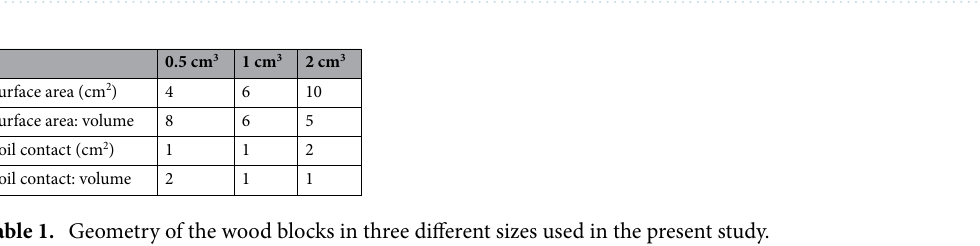
Figure 1. Scheme of the two hypothetical scenarios tested in the present study.